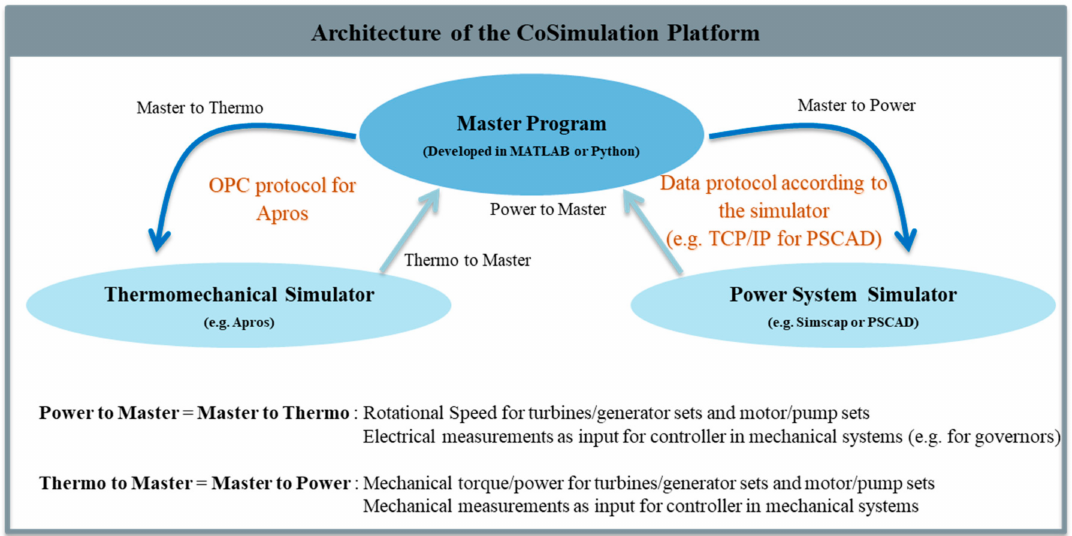
Figure 5. The proposed cosimulation architecture; arrows show data